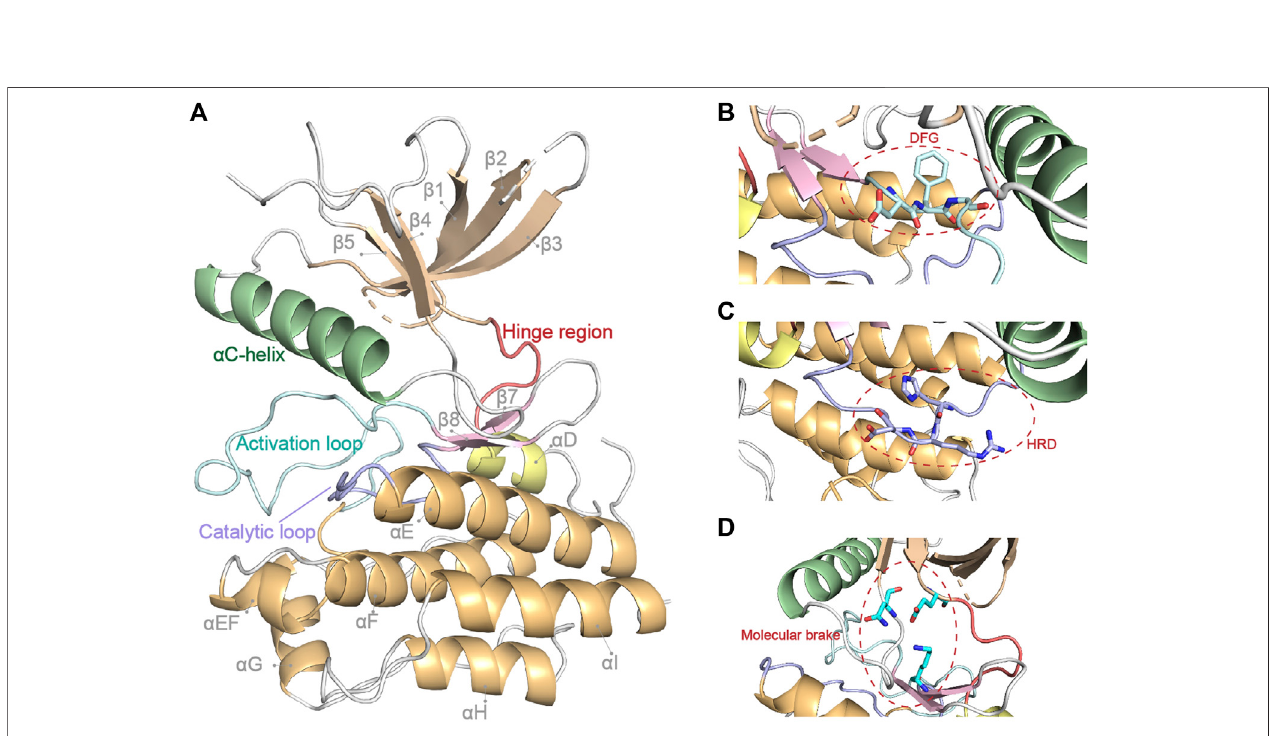
FIGURE2| FGFR1kinasedomainstructure(PDB:4UWY).Basicsecondarystructuresandcriticalregionsdescribedinthisreviewarehighlightedin (A) .Thecritical DFG, HRD motif and molecular brake are highlighted by close-up in (B – D) , respectively.